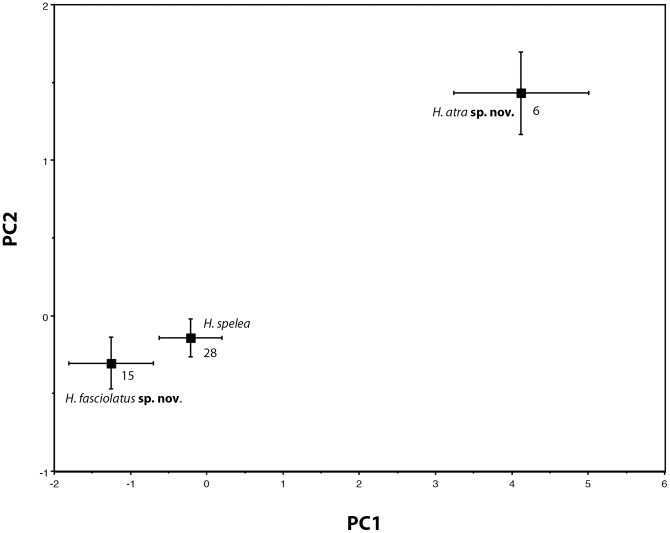
Summary of results for the PCAs of the morphological data for 49 Heteronotia specimens.Mean PC scores and standard deviations are shown with sample sizes noted.